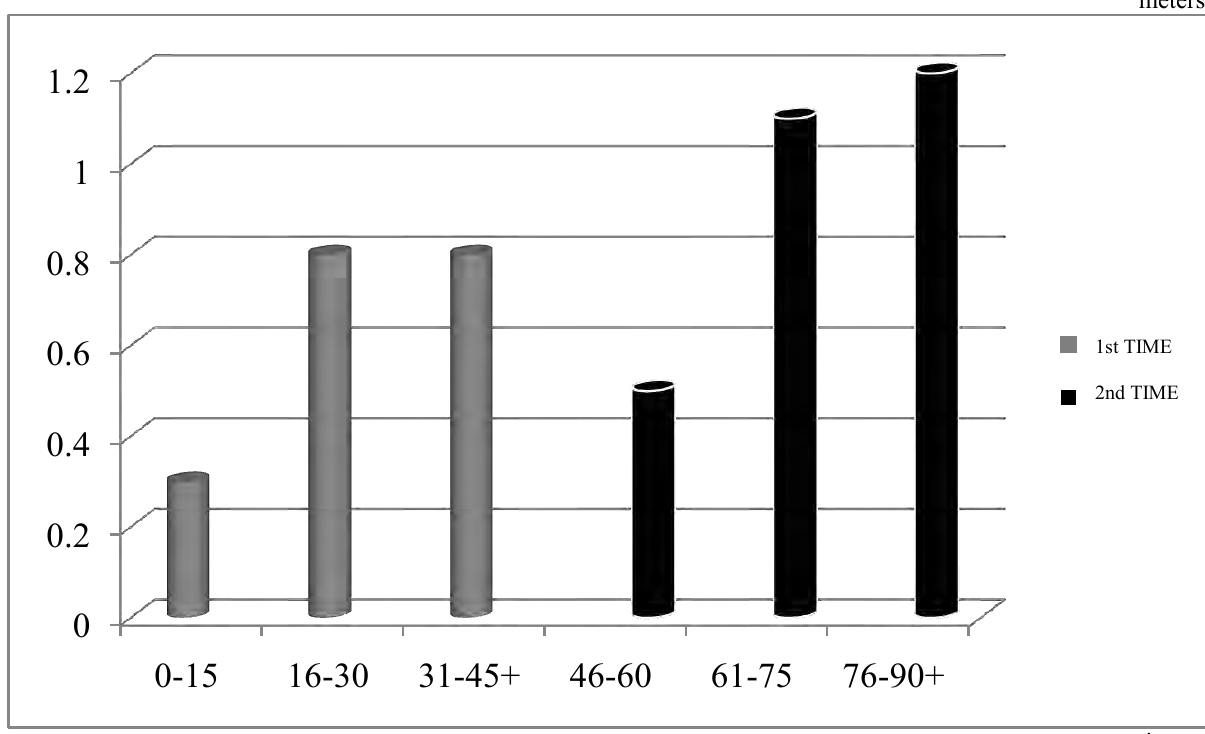
Fig.5. Mean quantity of violations, not noticed by referee (differentiated by 15 minutes’ periods)